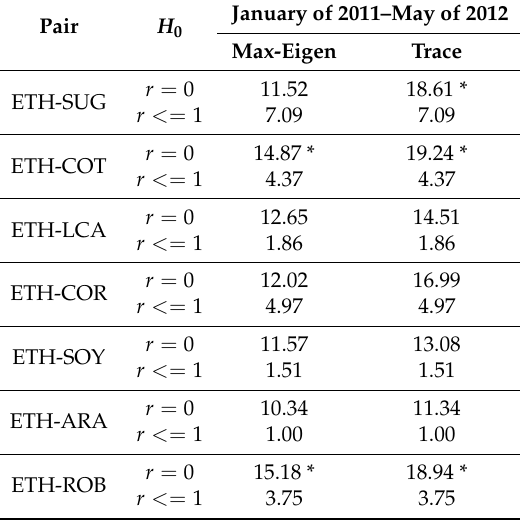
Table A2. The Johansen test for P 1 . Significance levels: 10% (*), 5% (**) and 1% (***).